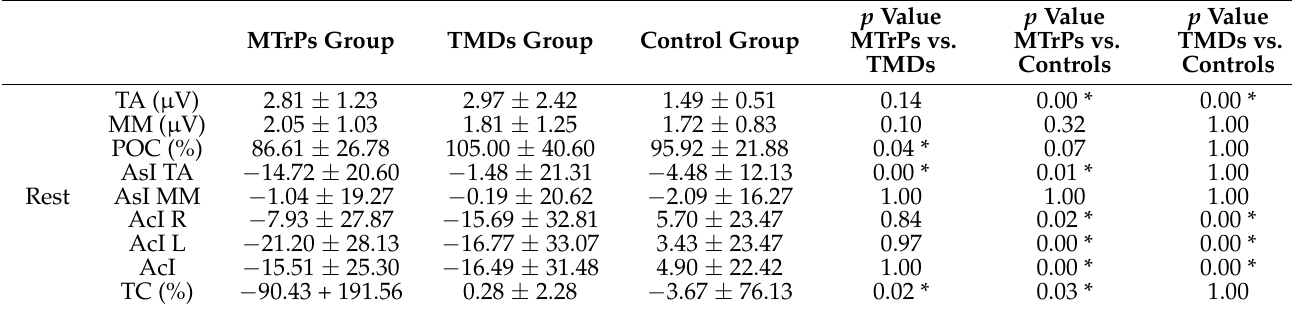
Table 3. Comparison of the mean values ( ± SD) of resting bioelectric activity of temporalis anterior (TA), masseter muscle (MM) and electromyographic indices between groups.